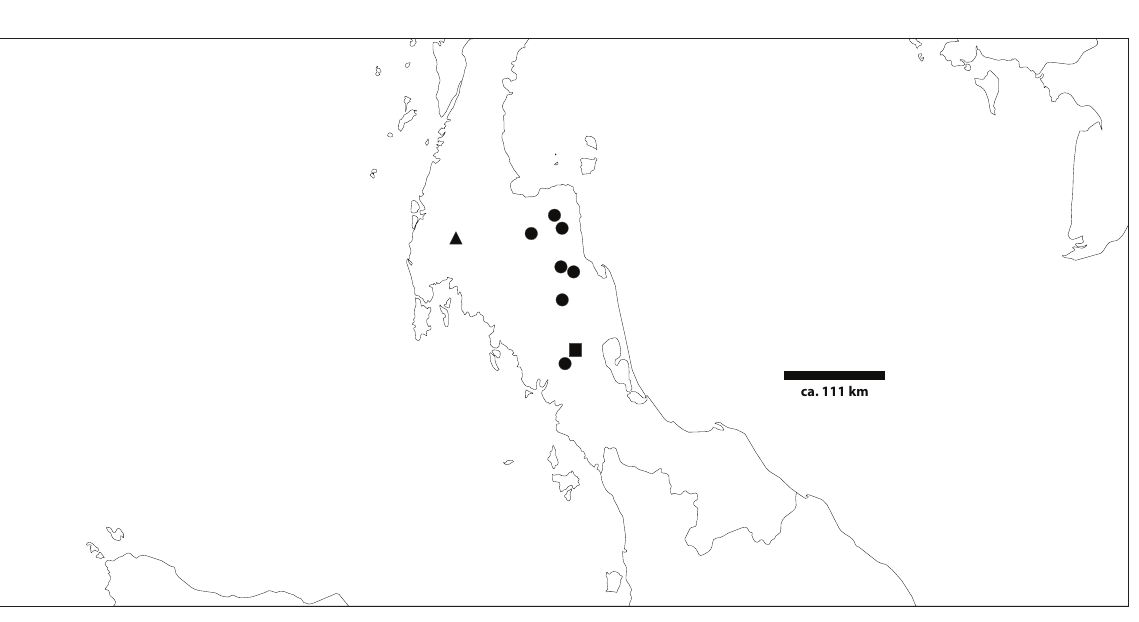
Fig. 6. Distribution of Winitia in Thailand. Winitia expansa Chaowasku (■), Winitia longipes (Craib) Chaowasku & Aongyong comb. nov. (●), and Winitia thailandana Chaowasku & Aongyong sp. nov.